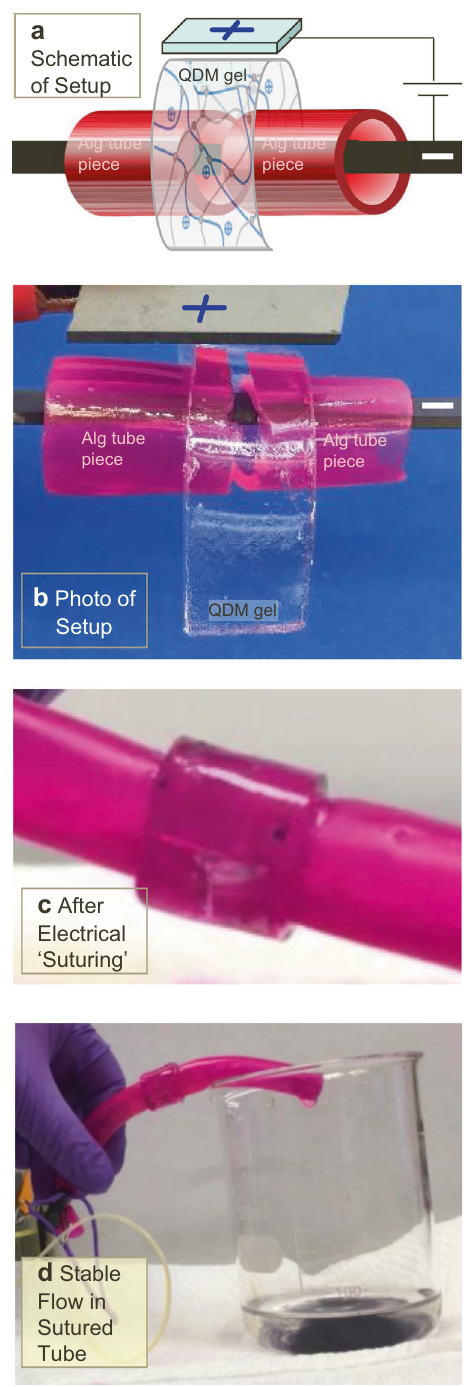
Fig. 4 Electrical “ suturing ” of two severed segments of a tube. A long QDM gel-strip is used as a sleeve around the two pieces of the Alg tube. The electrode orientation is as indicated. Schematic of the process is shown in ( a ) and a photo in ( b ). c Following this process, the Alg tube segments are found to be ‘ sutured ’ (joined) by the gel sleeve. d Stable fl ow occurs through the repaired tube to the waste beaker. The entire sequence of events is demonstrated by Supplementary Movie